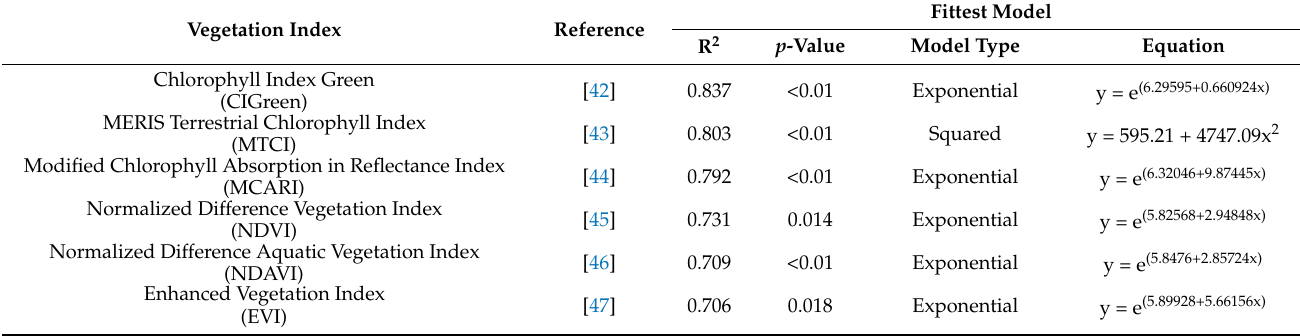
Table 2. Spectral vegetation indexes tested and fittest models results. CIGreen showed the highest R 2